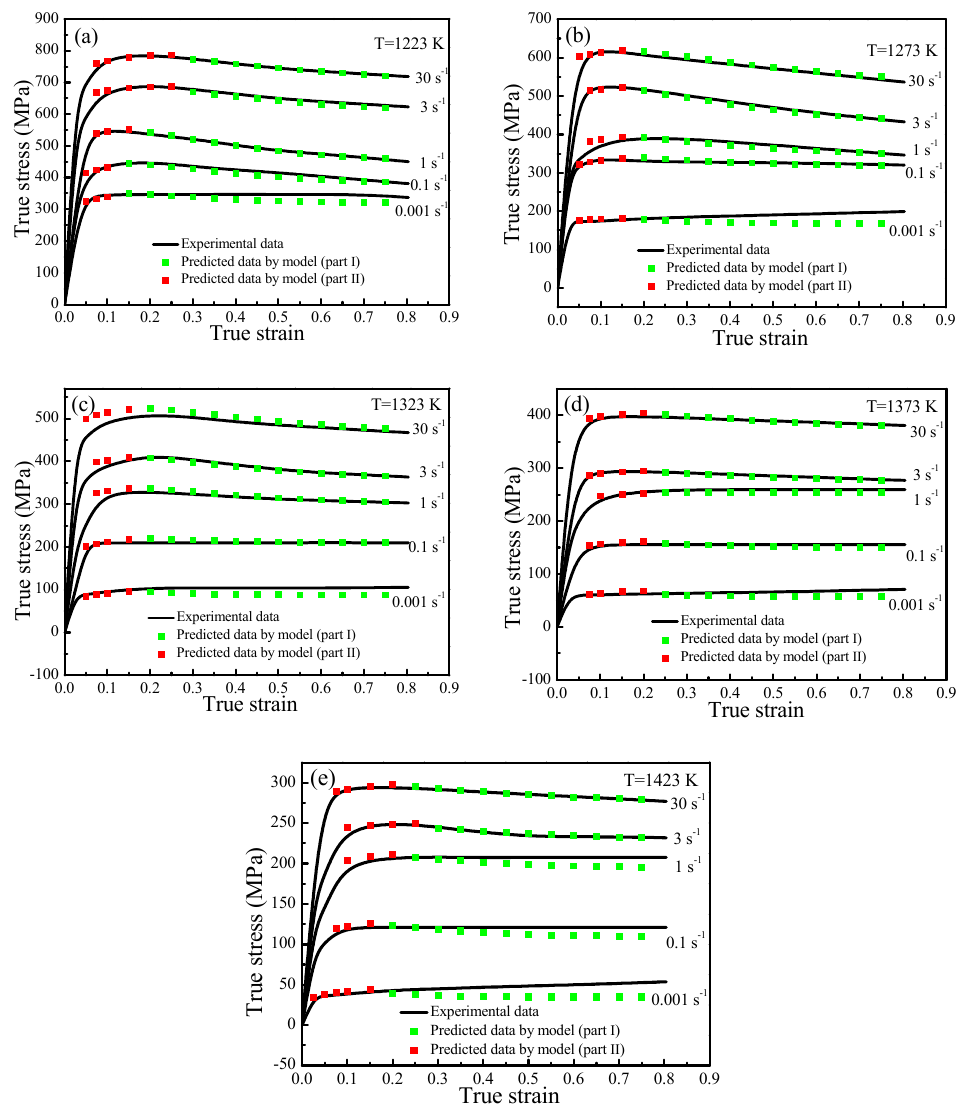
Figure 18. The comparison between the predicted and experimental flow stress curves under different deformation conditions: ( a ) 1223 K; ( b ) 1273 K; ( c ) 1323 K; ( d ) 1373 K; ( e ) 1423 K.